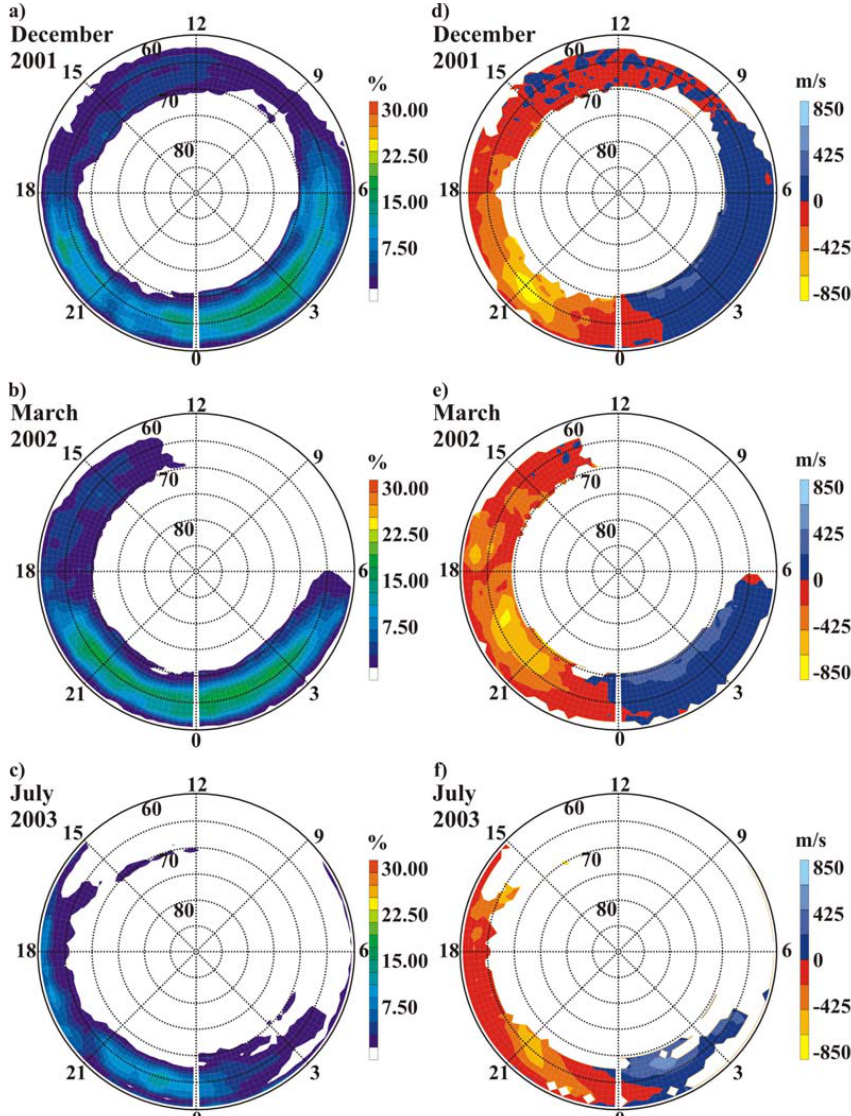
Fig. 2. King Salmon echo occurrence rate and averaged line-of-sight velocity for winter (December 2001, panels (a) and (d) ), equinox (March 2002, panels (b) and (e) ) and summer (July 2003, panels (c) and (f) ) in magnetic latitude – magnetic local time coordinates. Only data in beams 0-5 were considered.